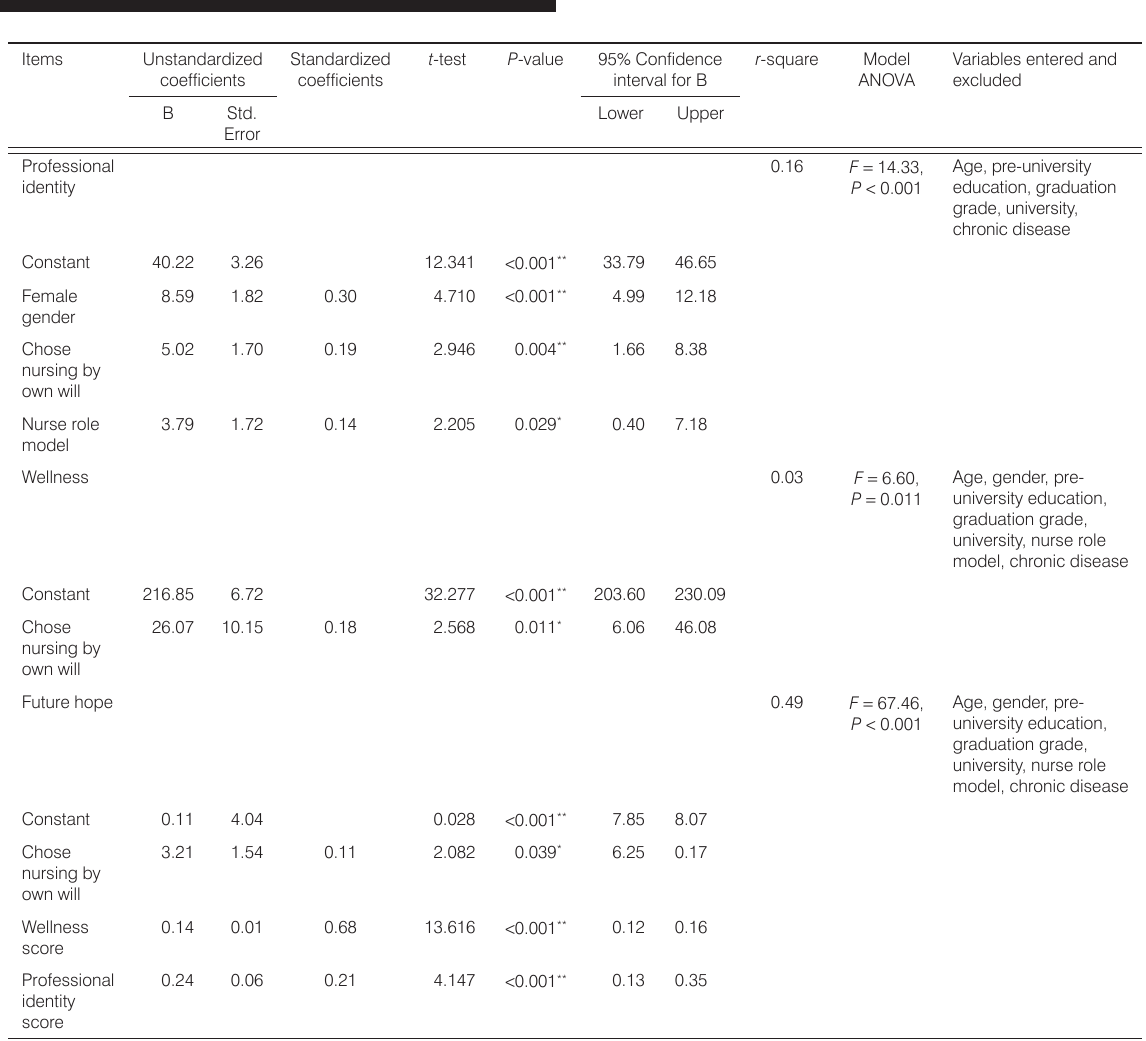
Table 7. Best fitting multiple linear regression model for the professional identity, wellness, and future hope score.